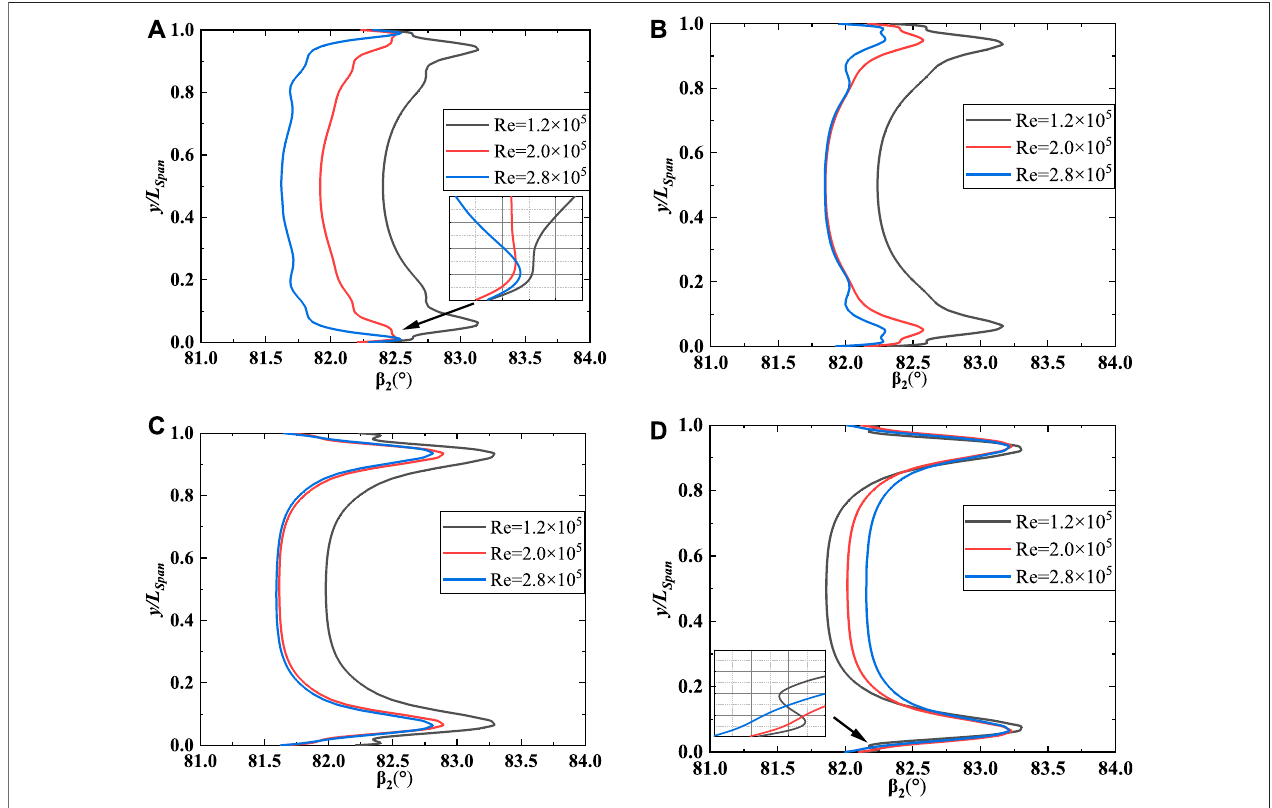
FIGURE 13 | Effect of roughness on outlet fl ow angle at different Reynolds numbers: (A) smooth, (B) 19 μ m, (C) 74 μ m, and (D) 180 μ m.